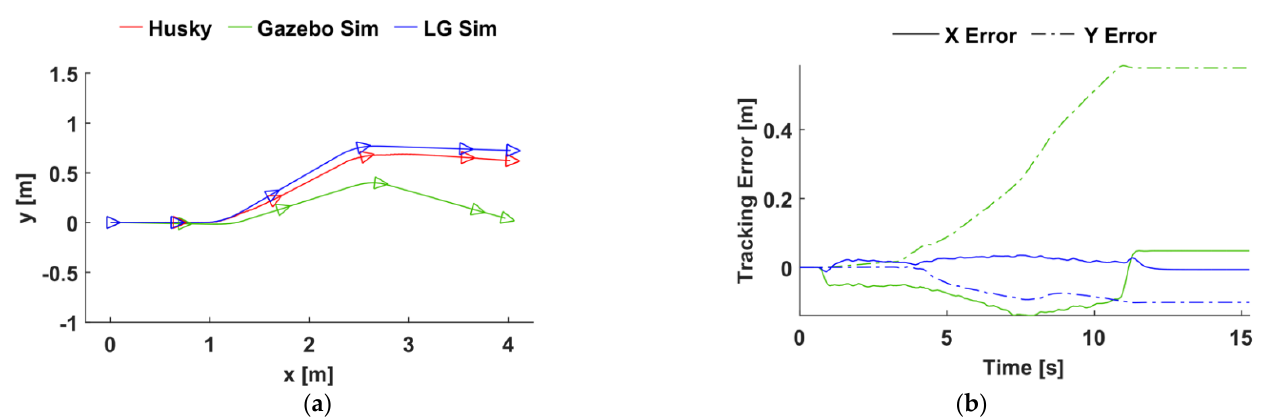
( b ) Figure 16. ( a ) Trajectory and ( b ) tracking error results of the LG and Gazebo simulations compared with experimental data for the obstacle avoidance maneuver. In each of the three presented maneuvers, the calibrated LG model provided a sig- nificantly more accurate trajectory response than the Gazebo simulation. The primary cause of error for the Gazebo simulation was excessive skidding, which could be observed during rotational movements of the Husky during the simulation. For the circle maneu- ver, this excessive skidding resulted in a smaller, oval-shaped trajectory compared with the larger, circular trajectory of the LG model. Similarly, for the S-bend and obstacle